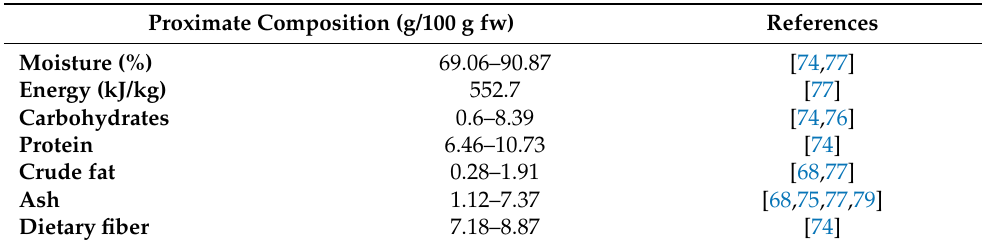
Table 1. Energetic value, proximate and chemical composition, and micro and macro elements of Daucus carota L. taproots. Proximate Composition (g/100 g